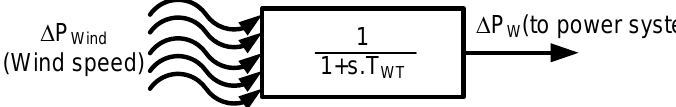
Figure 4. Block diagram of Wind turbine dynamics system.